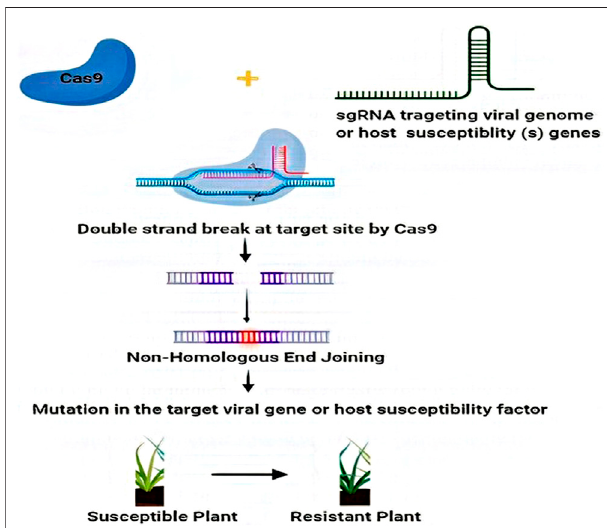
FIGURE 3 | Utilization of CRISPR/Cas systems against diverse plant viruses by targeting host susceptibility genes or viral genome. The viral genome DNA or RNA can be targeted, destroyed, or interfered with by CRISPR/Cas9 in the nucleus or in the cytoplasm, thus inhibiting plant viruses by CRISPR/Cas9 system-mediated adaptive immunity. Additionally, the mutation in host susceptibility factors edited by the CRISPR/Cas9 system further contributes to viral